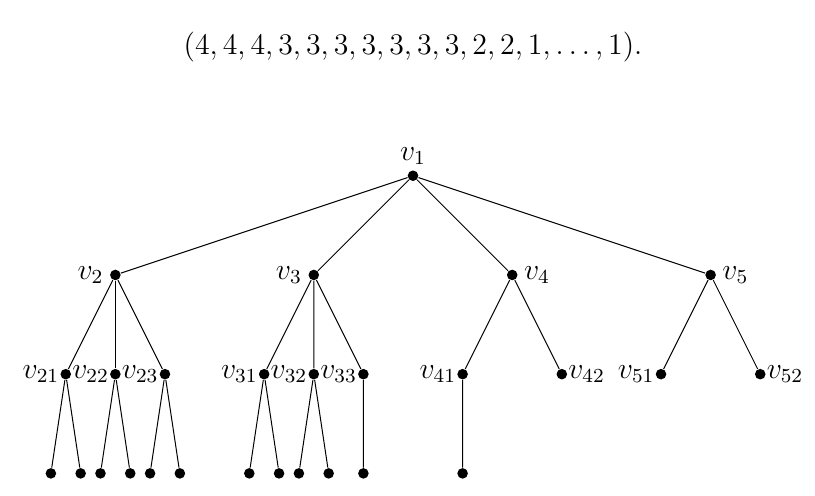
Figure 1: A greedy